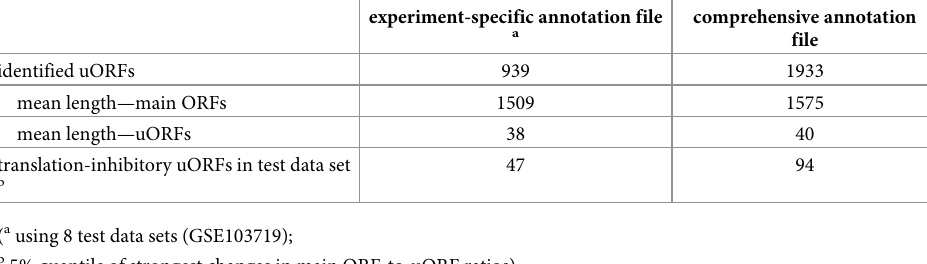
Table 1. Comparison of the performance of uORF-Tools for the 8 test data sets (GSE103719) using either the experiment-specific or the comprehensive annotation files.